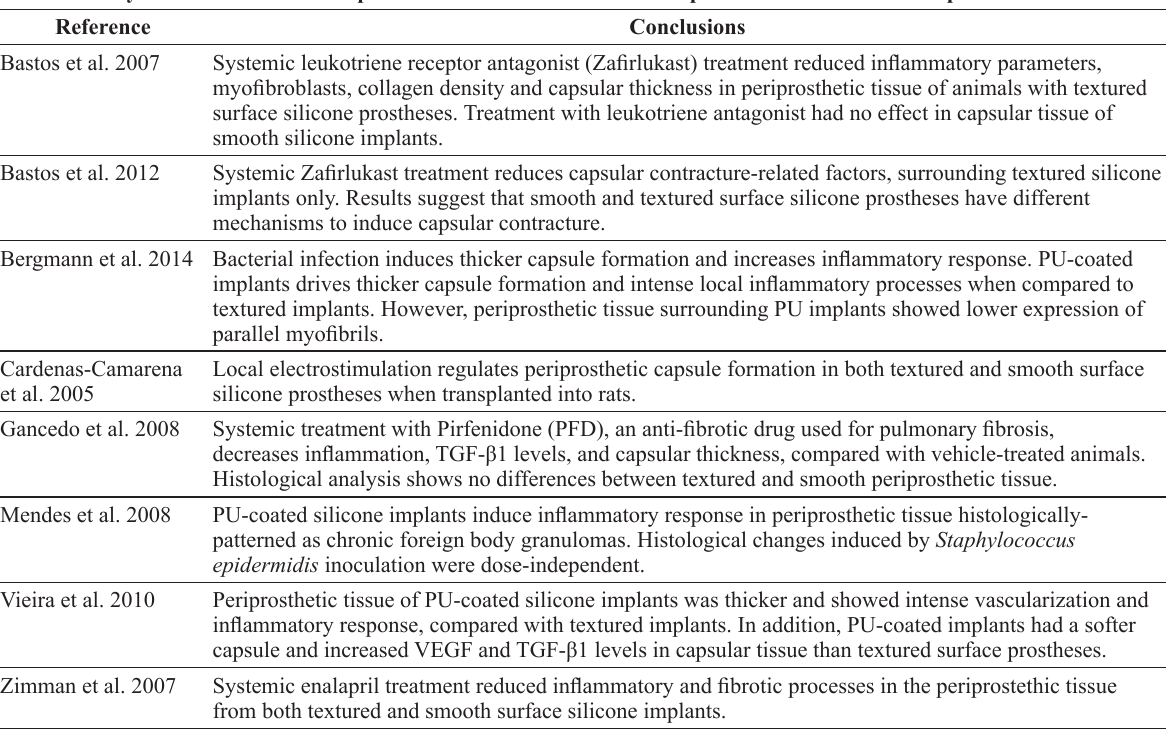
Summary of conclusions from capsular contracture studies after implantation of silicone mini-prostheses in rats. Reference